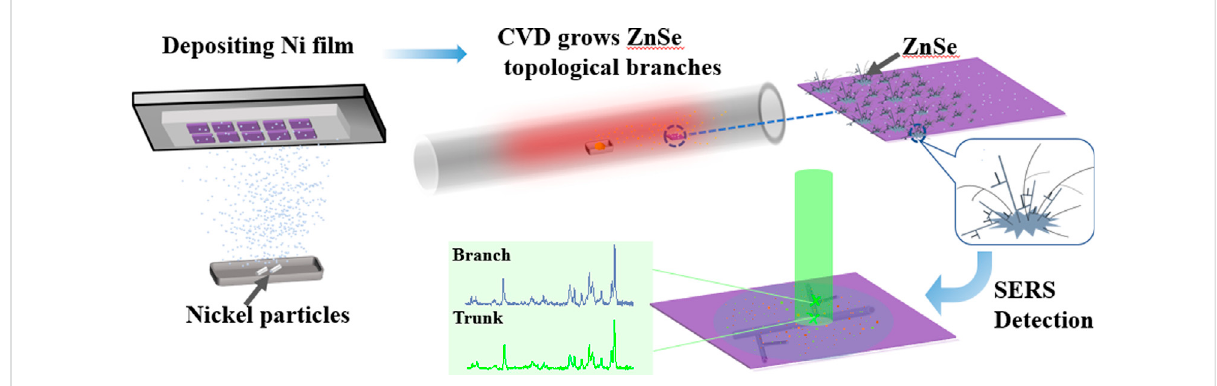
FIGURE 1 Diagram of the preparation of a ZnSe topological branched nanowire SERS substrate and the detection of SERS